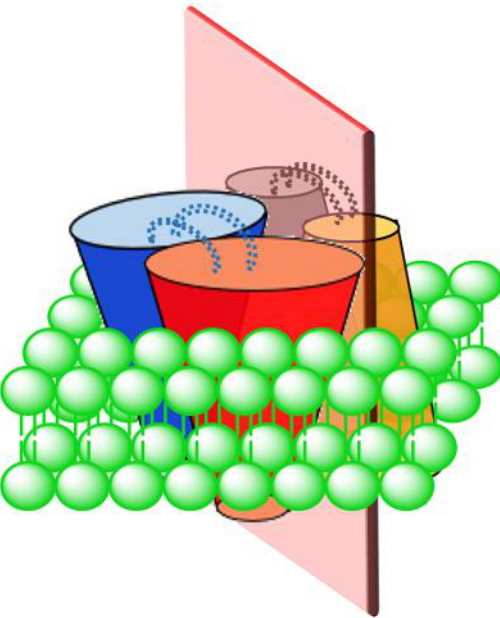
Figure 3. Schematic representation of a pseudosymmetric UCP tetramer. This tetramer is in fact a dimer of dimers with two tight-binding interfaces (between red and blue subunits and between yellow and gray subunits) and a loose-binding interface (shown with a light red plate). There are two salt-bridges between the monomers within each dimer shown with blue and grey dotted lines.